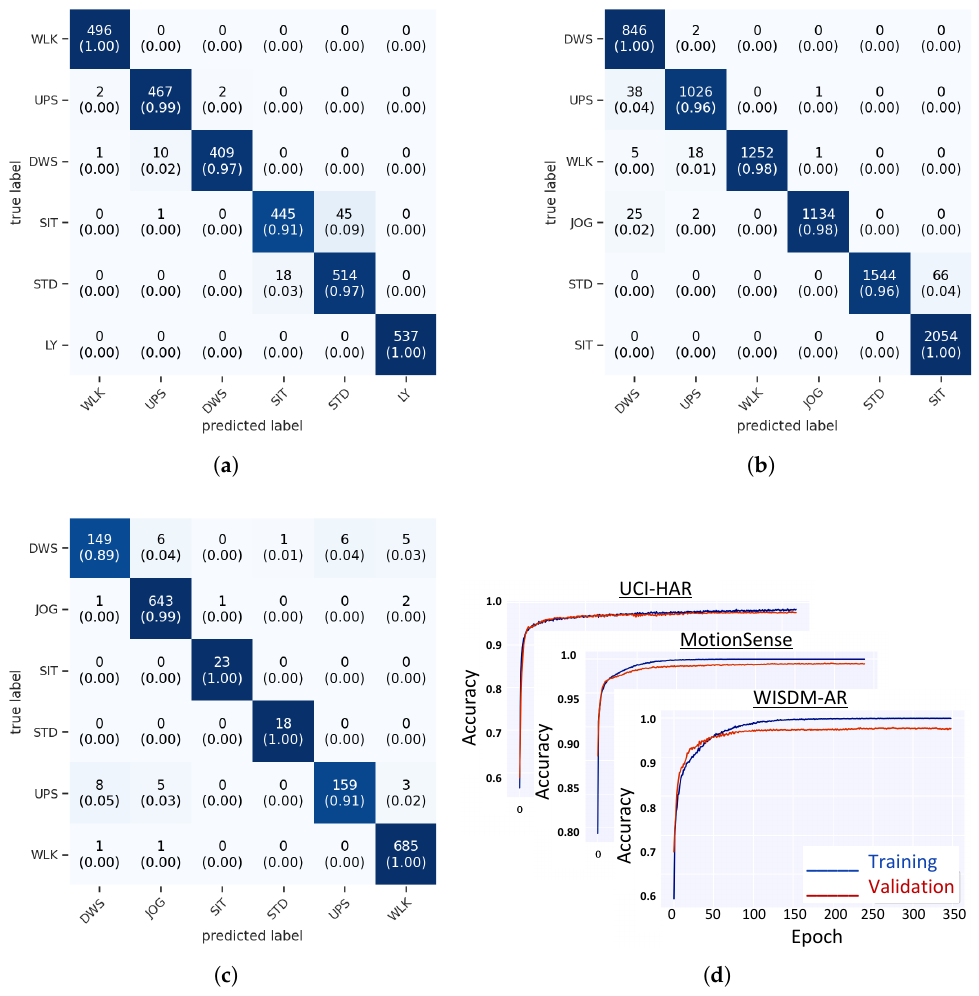
Figure 7. Confusion matrices of the CNN MF classifier for the test set of the selected datasets and the training curves of the proposed MF CNN classifier for the selected datasets. ( a ) UCI-HAR Confusion matrix. ( b ) MotionSense Confusion matrix. ( c ) WISDM Confusion matrix. ( d ) Training curves of the MF CNN classifier for all